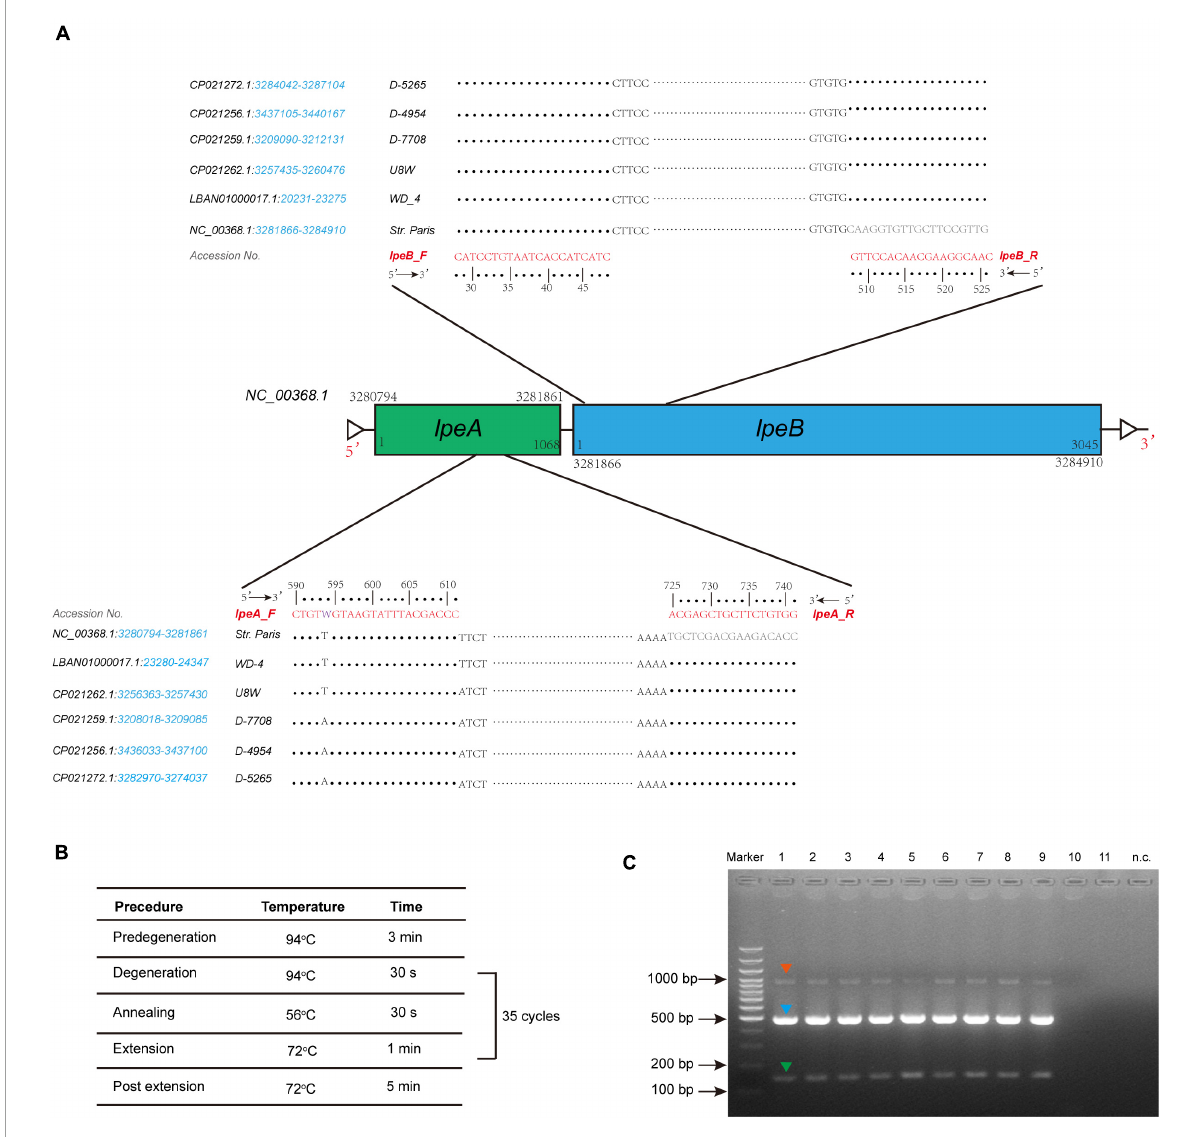
FIGURE5 Design of lepAB primers with genomic sequences from L. pneumophila harboring the lpeAB efflux, and multiplex PCR to detect lpeAB genes and their spatial arrangement. (A) Arrangement of the lpeAB is shown using L. pneumophila str. Paris as a reference. Primers and DNA sequences of lpeAB , and GenBank accession numbers are shown, and the blue italics indicate the gene location in the selected sequences of the strains. (B) PCR amplification conditions. (C) Representative results for detection of lpeAB efflux in L. pneumophila isolates. DNA electrophoresis shows specific lpeA targets (green arrow, 152 bp), lpeB targets (blue arrow, 499 bp), and lpeA-lpeB combined targets (red arrow, 1009 bp), which indicate the right arrangement of the two genes. Lanes 1-9 show positive for lpeAB efflux; lanes 10-11 show negative for lpeAB efflux; n.c. indicates negative control which used sterile water as a